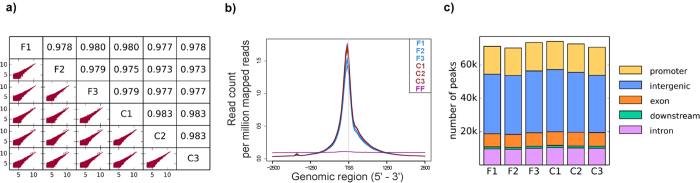
Quantitative comparison of fresh and cryopreserved cells.(A) Correlative analysis of the number of reads in 5 kb regions of the genome. The lower left triangle of the figure shows the scatter plots of the log2 read counts for each pair of technical replicates (5 kb regions with less than 10 read counts were excluded from the analysis). The upper right triangle displays the corresponding values of the Pearson correlation coefficient. (B) Average read profiles across the transcriptional start sites (TSS) using a 2.5 Kb window size. The overall pattern is very similar between fresh and cryopreserved iMNs. (C) Location-based distribution analysis: the distribution of neighboring genomic features to open-chromatin regions is highly similar between fresh and cryopreserved samples. (F = fresh, FF = flash-frozen, C = cryopreserved).